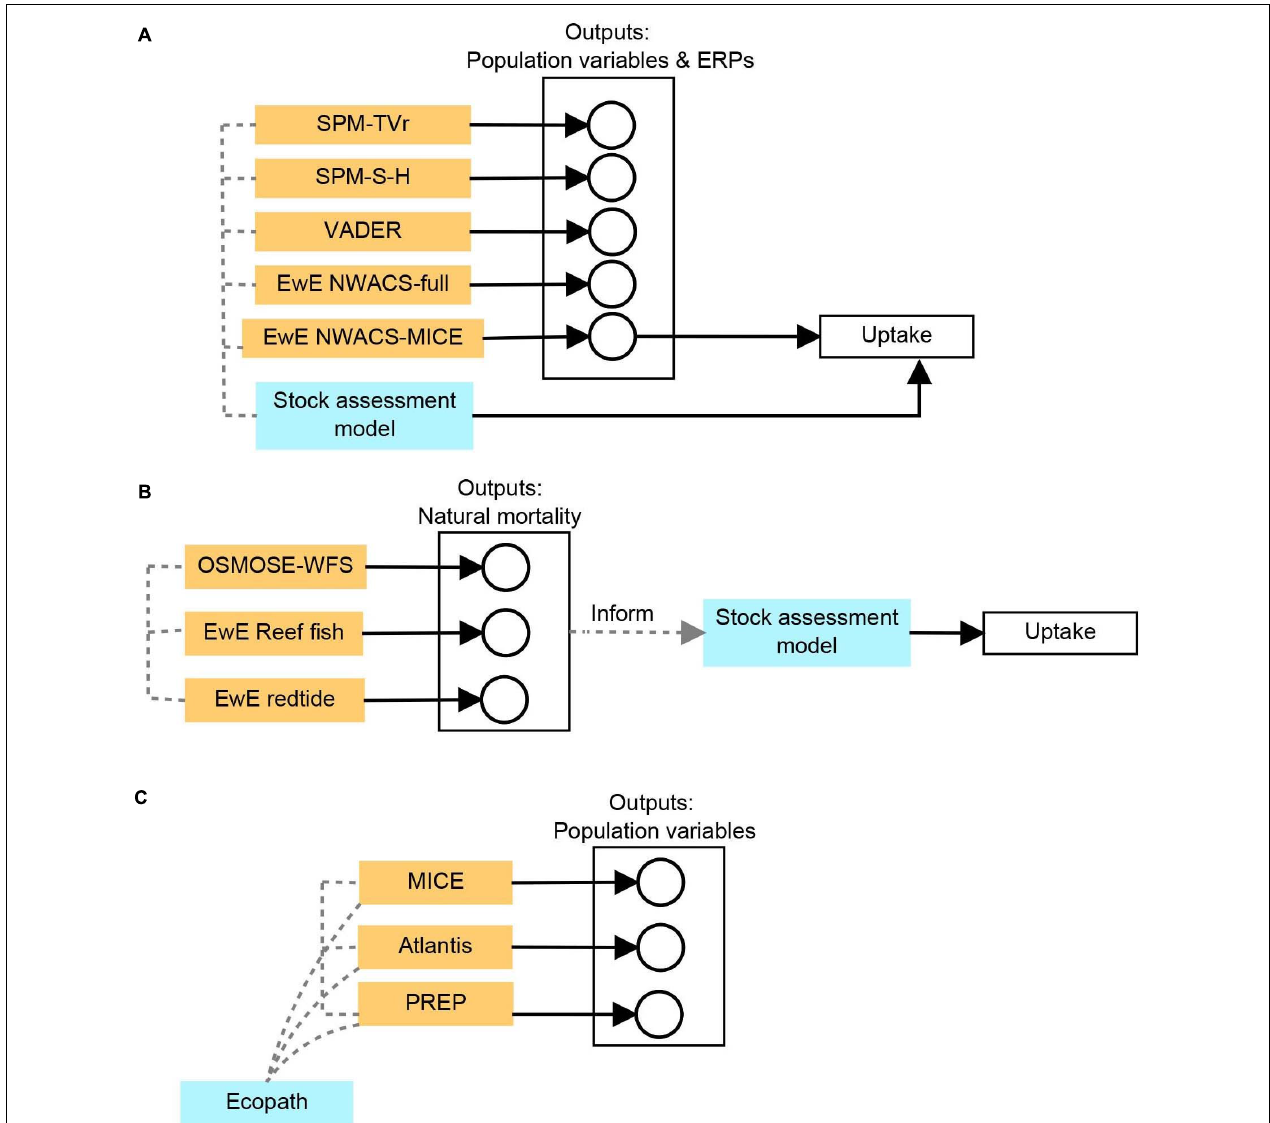
FIGURE 1 | A visual summary of the model sets and qualitative synthesis approach used in each case study. (A) Atlantic menhaden, (B) Gulf of Mexico gag and red grouper, and (C) sardine and anchovy in the California Current. In all case studies, data sets used to calibrate and parameterize ensemble models were shared across models depending on applicability, and Information derived from models within the set were shared between models. Solid black arrows represent unidirectional information flow of outputs and towards management uptake. Dashed lines information sharing between models in the ensemble set (e.g., predation rates in one model inform natural mortality rates in